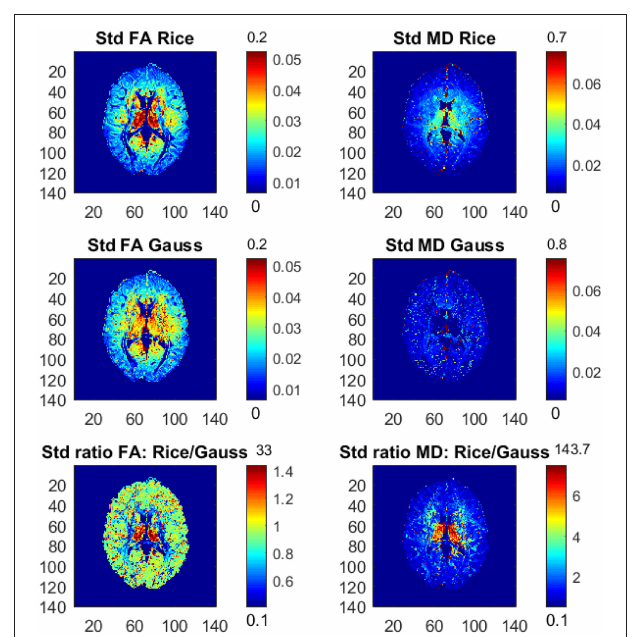
FIGURE 2 | Posterior standard deviations and ratios of posterior standard deviations of FA and MD for the Rician and Gaussian DTI models, using the whole dataset with all b -values up to b = 10,000 s/mm 2 . The color bars are shown for the mid 95% values and the minimum and maximum values are marked out at the bottom and top of the color bars,